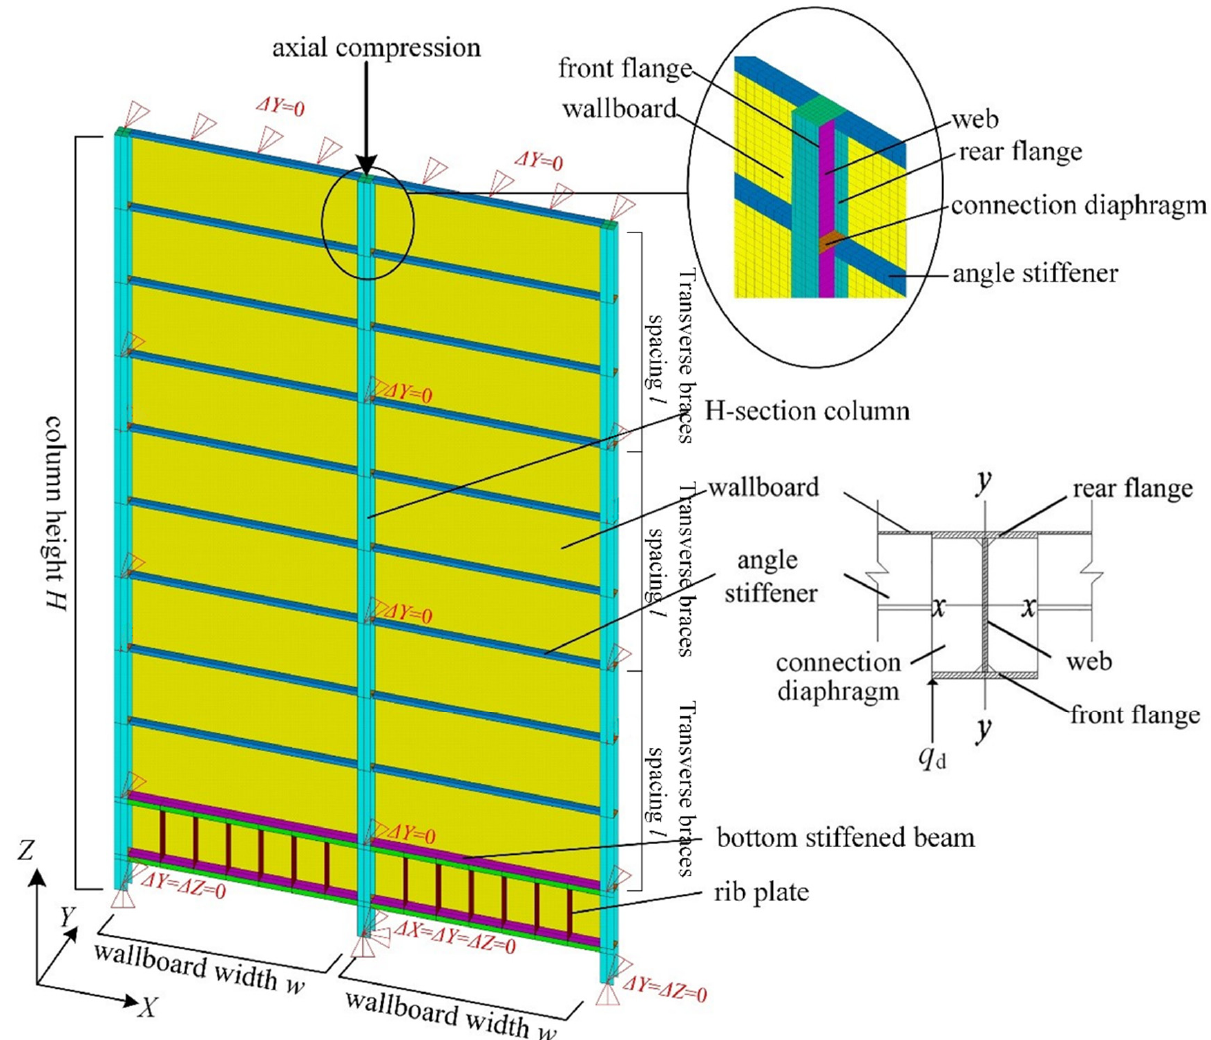
Figure 2. Schematic drawing of wall–column structure system.